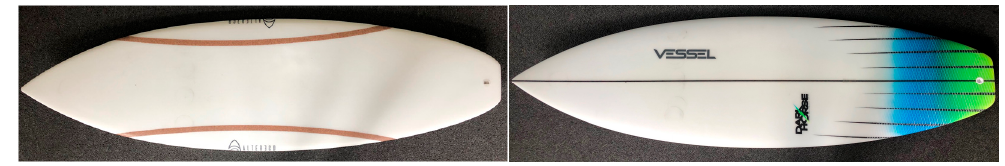
Figure 1. Surfboards tested. Alterego ( left ) and Vessel Darkhorse ( right ).